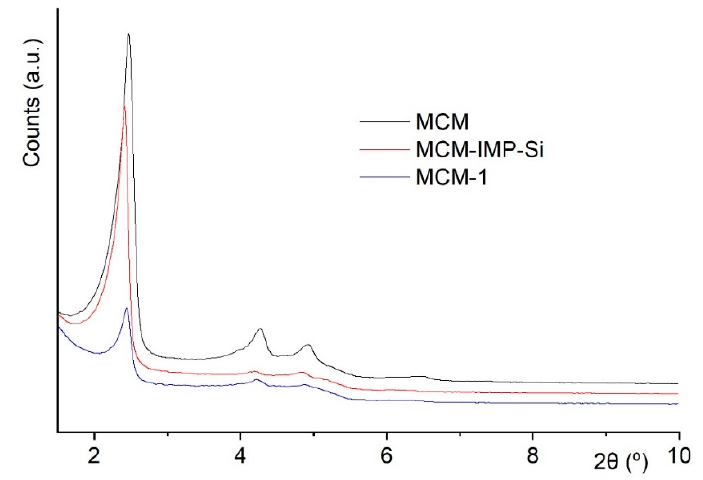
Figure 3. XRD powder patterns of materials MCM, MCM-IMP-Si, and MCM-1.